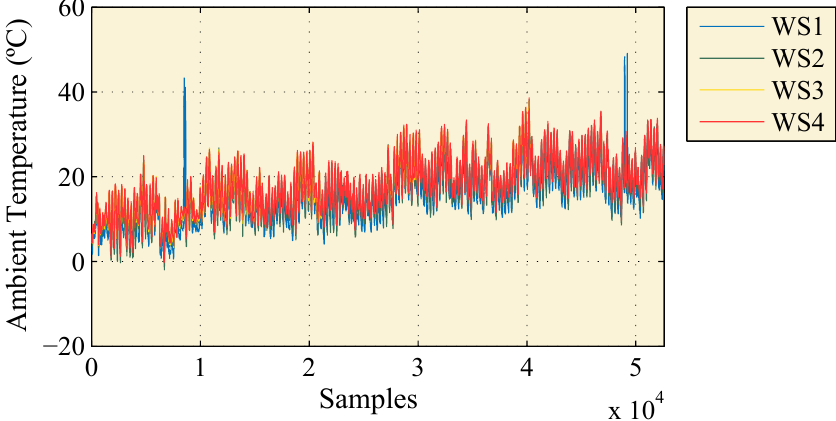
Figure 4. Evolution of ambient temperature with